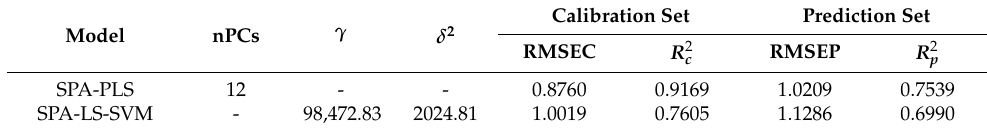
Table 3. Prediction parameters of SPA-PLS and SPA-LS-SVM based on characteristic wavelength variables for the spectrophotometer experiment.